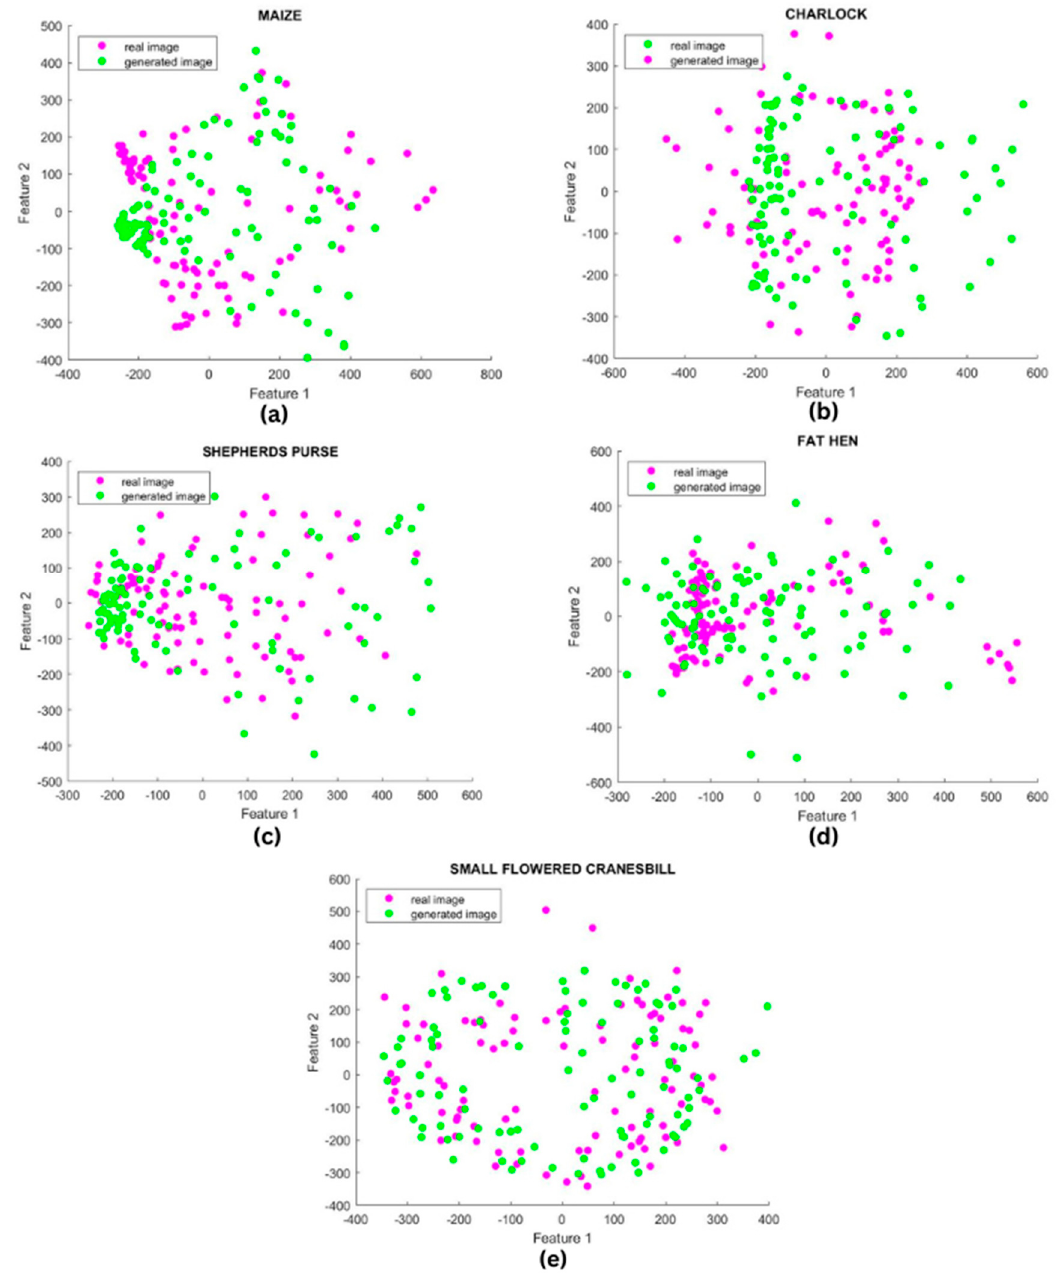
Figure 7. t-SNE visualization plots for real (blue points) and synthetic (red) images for all five clas- ses—(a) Maize, (b) Charlock, (c) Shepherd’s purse, (d) Fat Hen, and (e) Small-flowered Cranesbill. classes—( a ) Maize, ( b ) Charlock, ( c ) Shepherd’s purse, ( d ) Fat Hen, and ( e ) Small-flowered